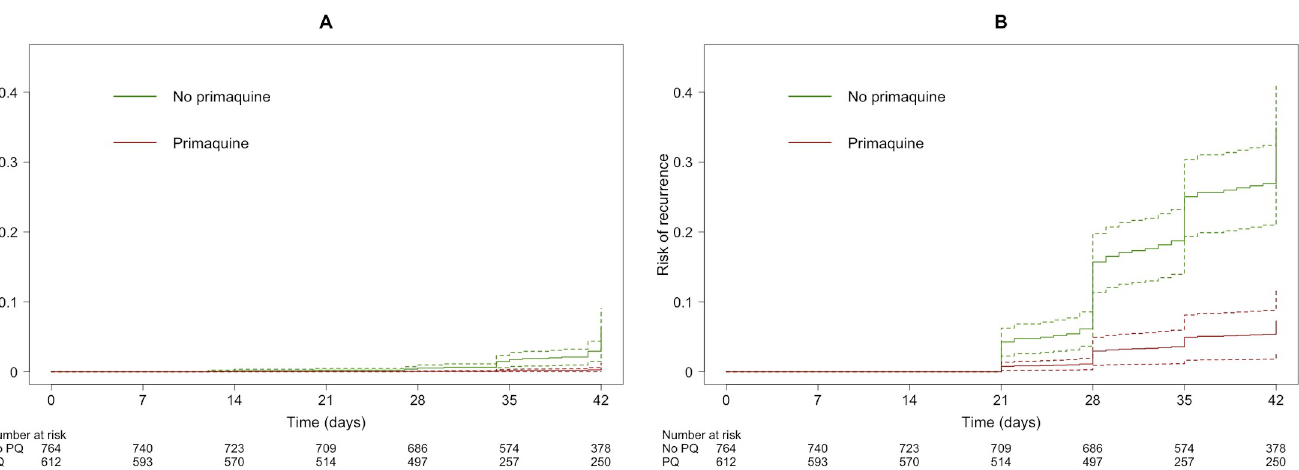
PLOS Medicine| https://doi.org/10.1371/journal.pmed.1002928 October 4,